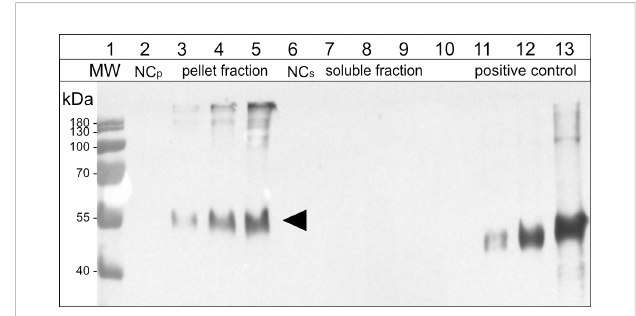
FIGURE 5 Immunoblot analysis of the soluble and pellet fractions obtained from agroin fi ltrated leaf samples expressing the antigen-fusion (15-kDa- b - zein-Opt3a12- fl ag). Lane 2-5: pellet fraction, solubilized with reducing and denaturing buffer; Lane 6-9: soluble fraction, extracted in saline buffer containing non-ionic detergent. Lanes 3 and 7: 15-kDa- b -zein- antigen fusion expressed on its own. Lanes 4 and 8: 15-kDa- b -zein- antigen fusion when co-expressed with Zera-EGFP. Lanes 5 and 9: 15- kDa- b -zein-antigen fusion when co-expressed with Zera-EGFP and 16-kDa- g -zein-BFP. NCp and NCs – pellet or soluble fraction, respectively, obtained from leaves in fi ltrated with an empty vector control. Lane 11-13, positive control (200, 500 and 1500 ng of a fl ag- tagged standard protein). MW – protein ladder. Bands corresponding to the 15-kDa- b -zein-Opt3a12- fl ag fusion with a molecular mass of approximately 50 kDa are indicated by an arrow. The estimates of relative quantities were based on three blots using extracts from three independent in fi ltration experiments.